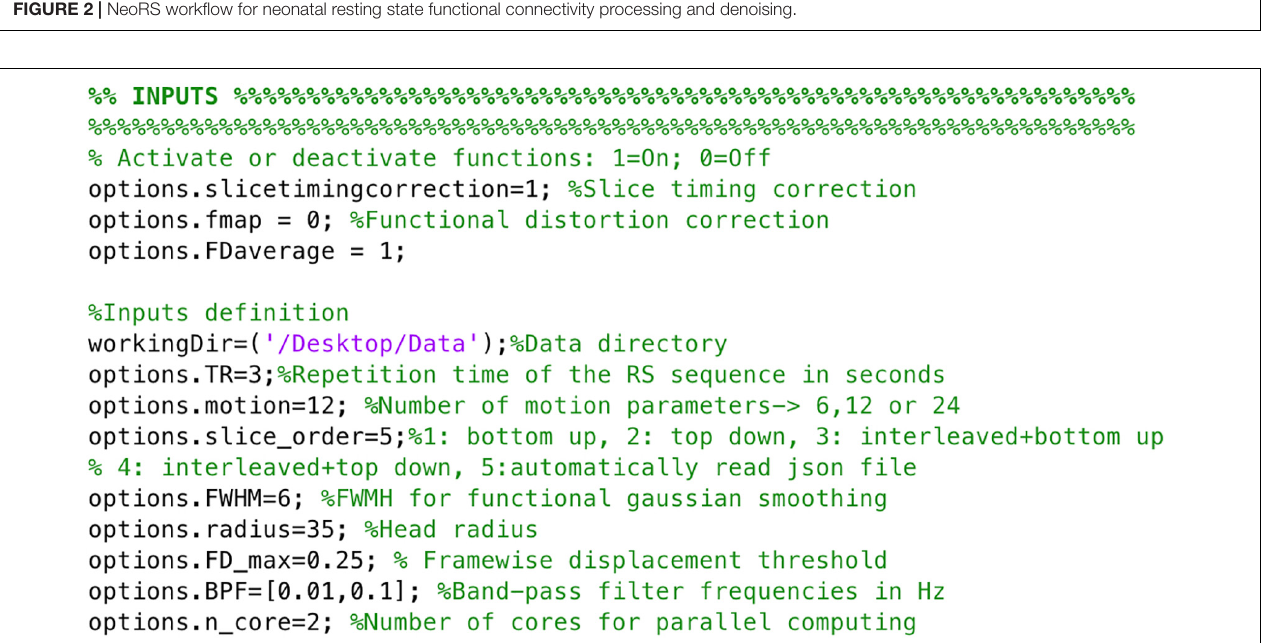
FIGURE 2 | NeoRS workflow for neonatal resting state functional connectivity processing and denoising.